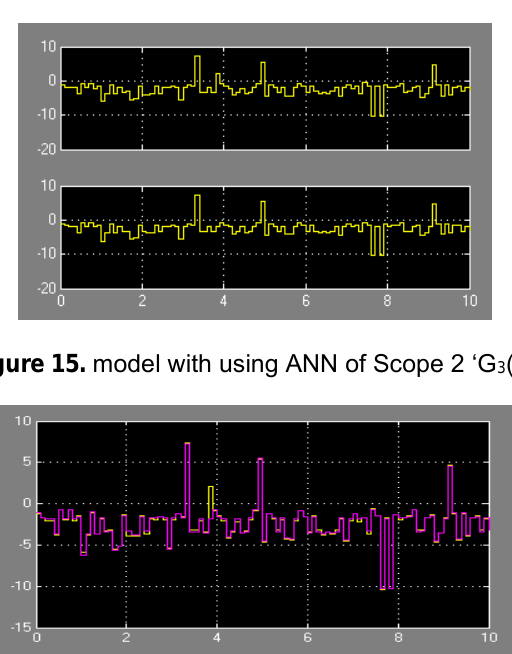
Figure 14. model with using ANN of Scope 3 ‘G 2 (u)’